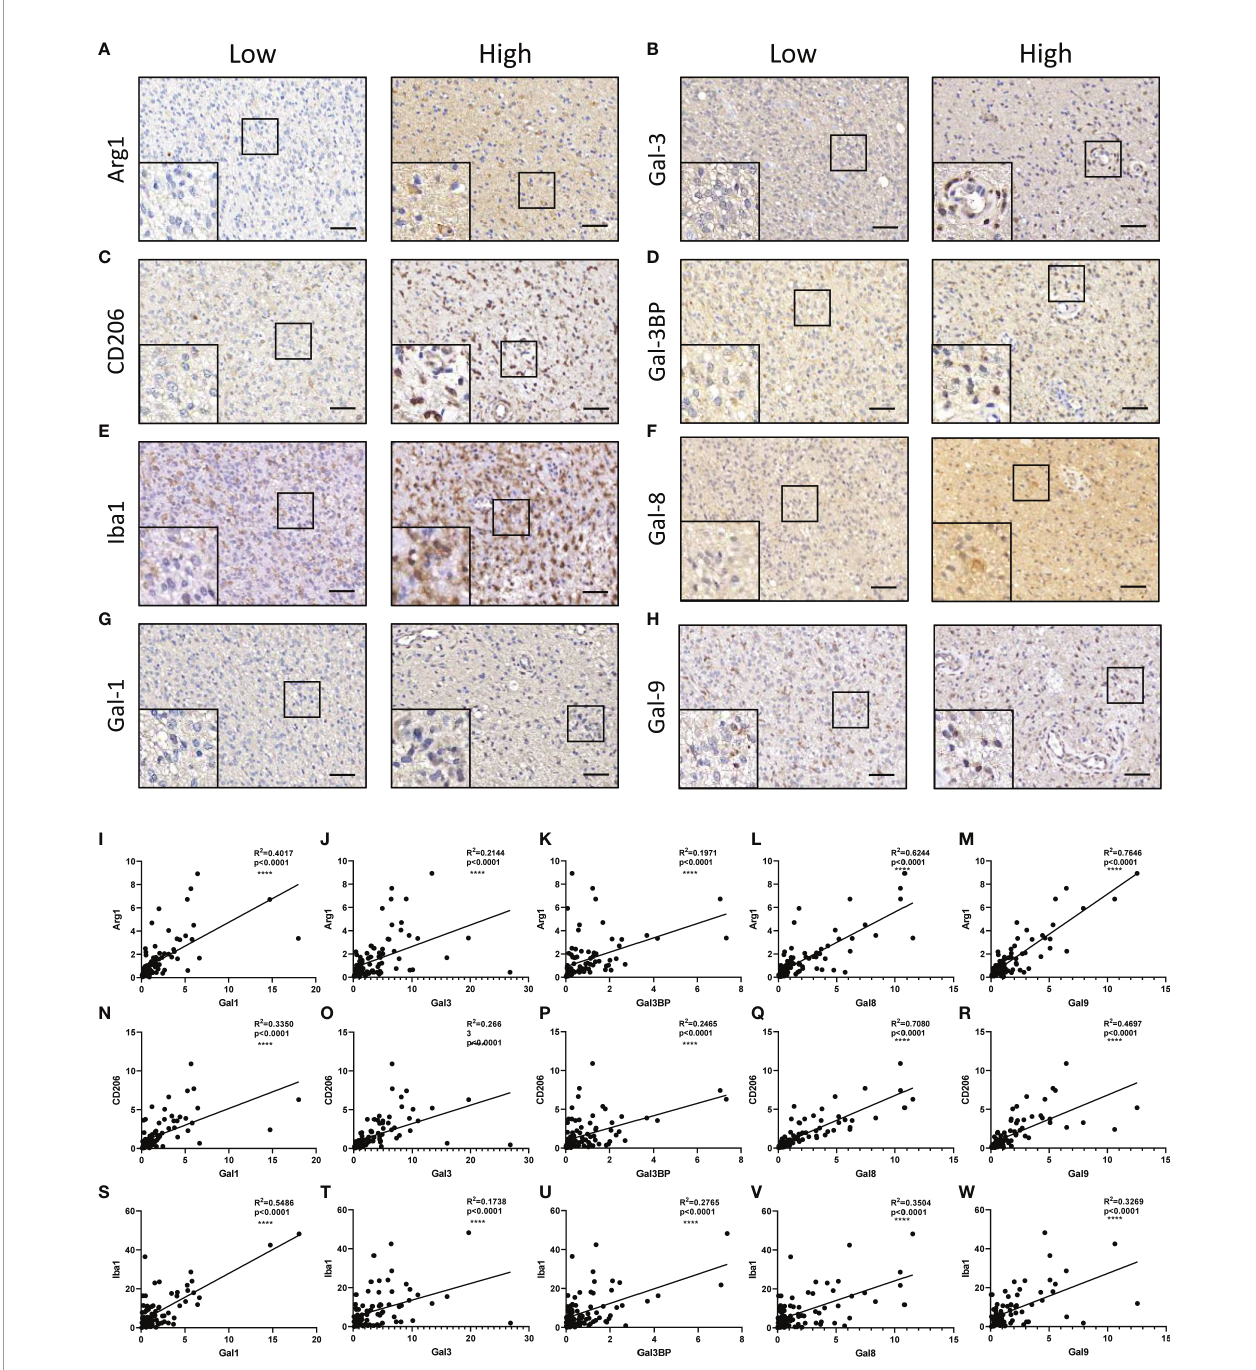
FIGURE 6 | Correlations between galectins and M2-TAMs in fi ltration at the protein level in glioma tissues. Arg1 (A) , Gal-3 (B) , CD206 (Marker for M2-TAMs) (C) , Gal-3BP (D) , Iba1 (marker for pan TAMs) (E) , Gal-8 (F) , Gal-1 (G) , and Gal-9 (H) are shown. The scale bar measures 40 m m. (I – M) Pearson correlation analysis of the positive stain ratio of Arg1 and Galectins. (N – R) Pearson correlation analysis of the positive stain ratio of CD206 and Galectins. (S – W) Pearson correlation analysis of the positive stain ratio of Iba1 and Galectins. TAMs, tumor-associated macrophages